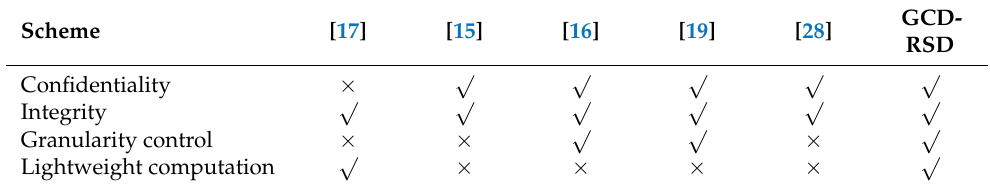
Table 1. The comparison of security and performance features for [15–17,19,28] and GCD-RSD.